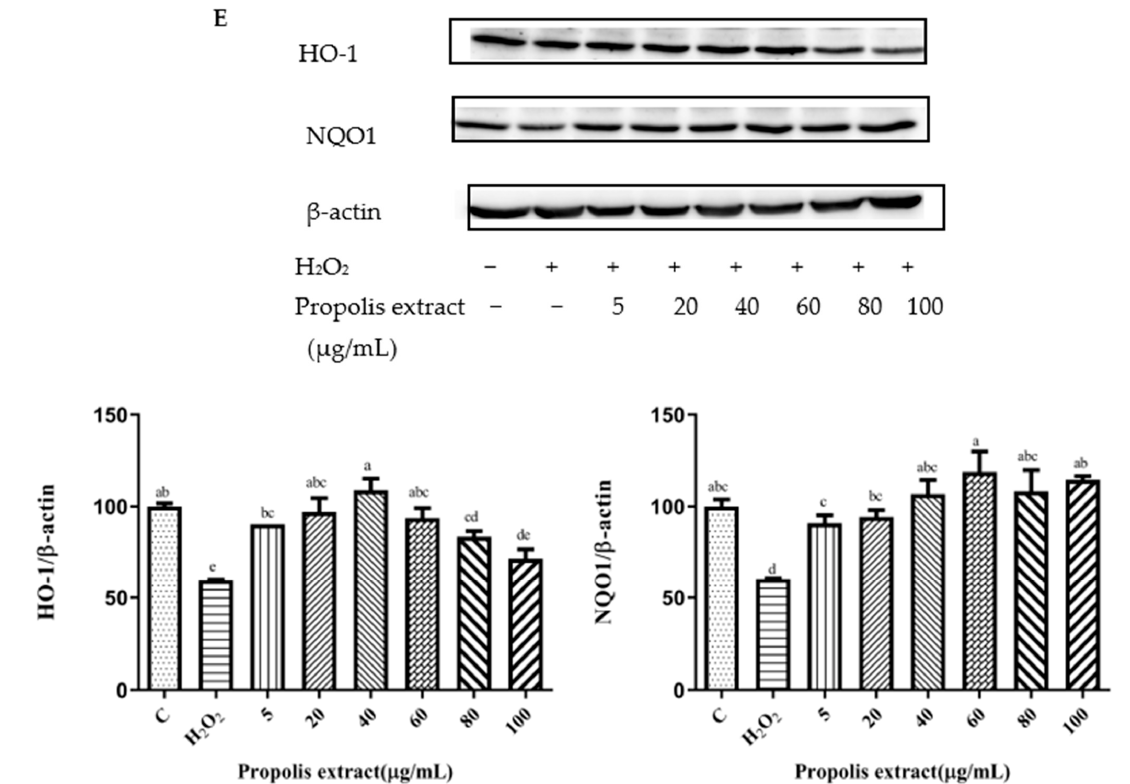
Figure 6. HO-1 and NQO1 expression induced by individual flavonoids (chrysin, pinocembrin, galangin, and pinobanksin) and propolis extract in 150 µ M H 2 O 2 -induced H9c2 cells. H9c2 cells were stimulated with different concentrations of phytochemicals (chrysin, pinocembrin, galangin, pinobanksin, and propolis extract) for 12 h and then treated with 150 µ M H 2 O 2 for 1 h; finally, protein expression was detected via Western blot. β -actin was used as an internal control. ( A ) HO-1 and NQO1 expression in chrysin-induced H9c2 cells. ( B ) HO-1 and NQO1 expression in pinocembrin- induced H9c2 cells. ( C ) HO-1 and NQO1 expression in galangin-induced H9c2 cells. ( D ) HO-1 and NQO1 expression in pinobanksin-induced H9c2 cells. ( E ) HO-1 and NQO1 expression in propolis- extract-induced H9c2 cells. Values are expressed as the mean ± SEM ( n = 3). Values with different